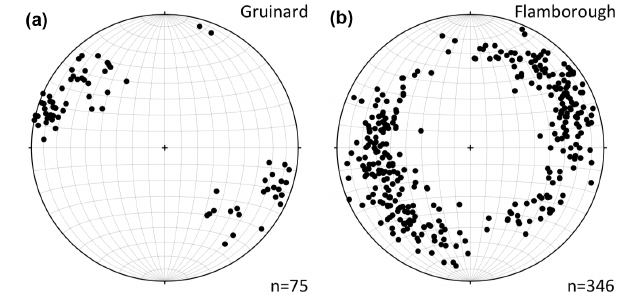
Figure 2. Stereographic projections (equal area, lower hemisphere) showing two natural fault datasets. (a) Poles to deformation bands (small offset faults; n = 75) measured in Triassic sandstones at Gru- inard Bay, NW Scotland (Healy et al., 2006a, b). These data were collected from a small contiguous outcrop approximately 10m 2 in area. (b) Poles to faults measured in Cretaceous chalk at Flambor- ough Head, NE England ( n = 346). These data have been taken from a figure published in Peacock and Sanderson (1992) and re- plotted in the same format as those from